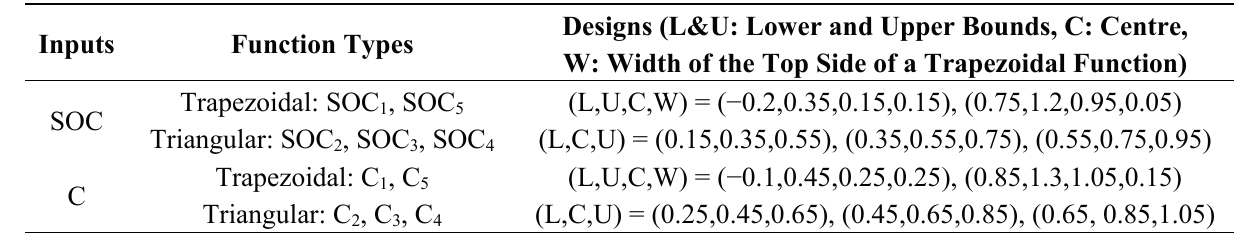
Figure 1. Fuzzified GA scheme (FGAS). Table 2. Design of fuzzy sets of inputs of